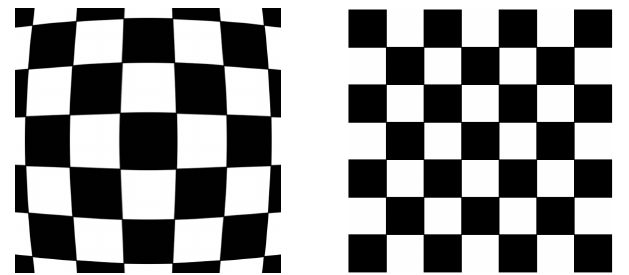
Figure 5. Demonstration of required calibration of fish-eye lens camera to “flatten” out the image to maintain consistent